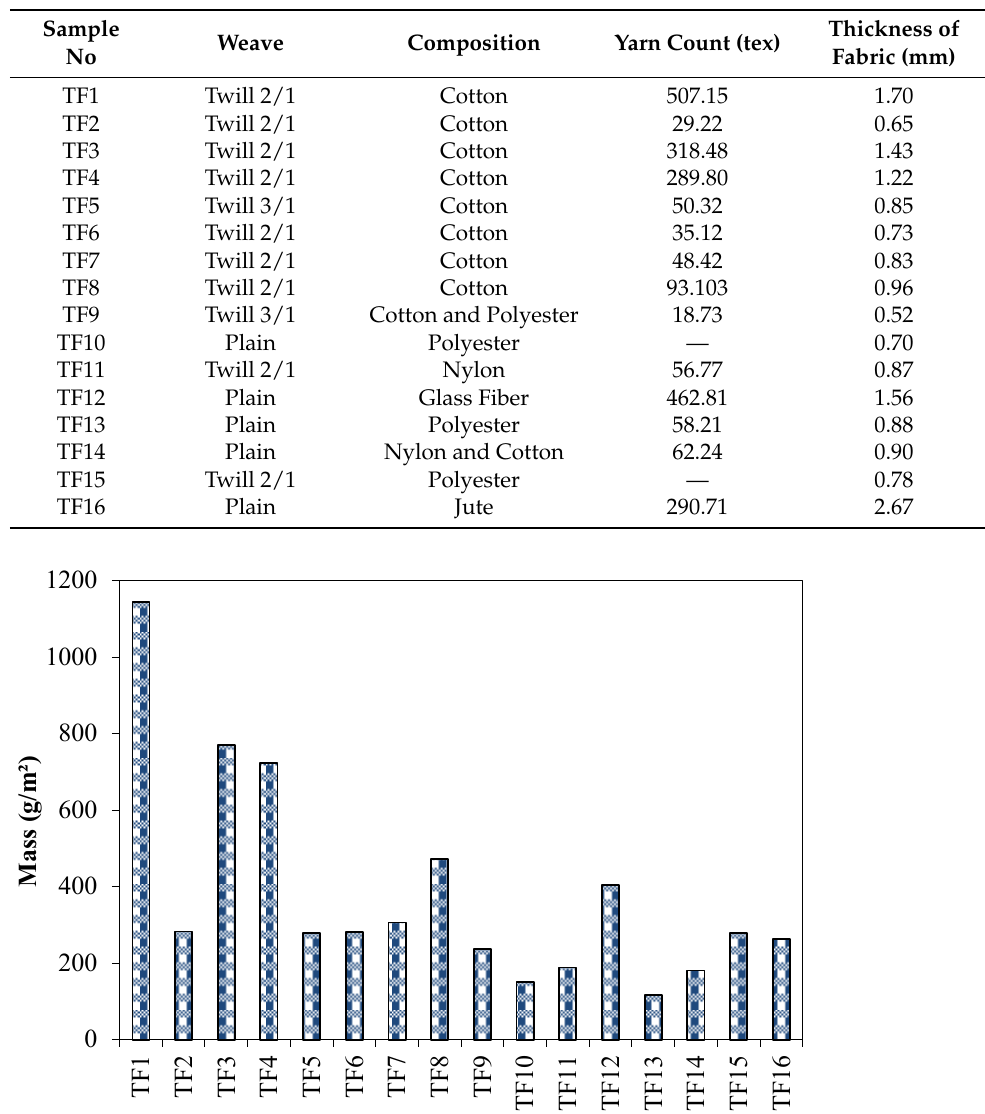
Table 6. Fabric types of tested textile specimen.